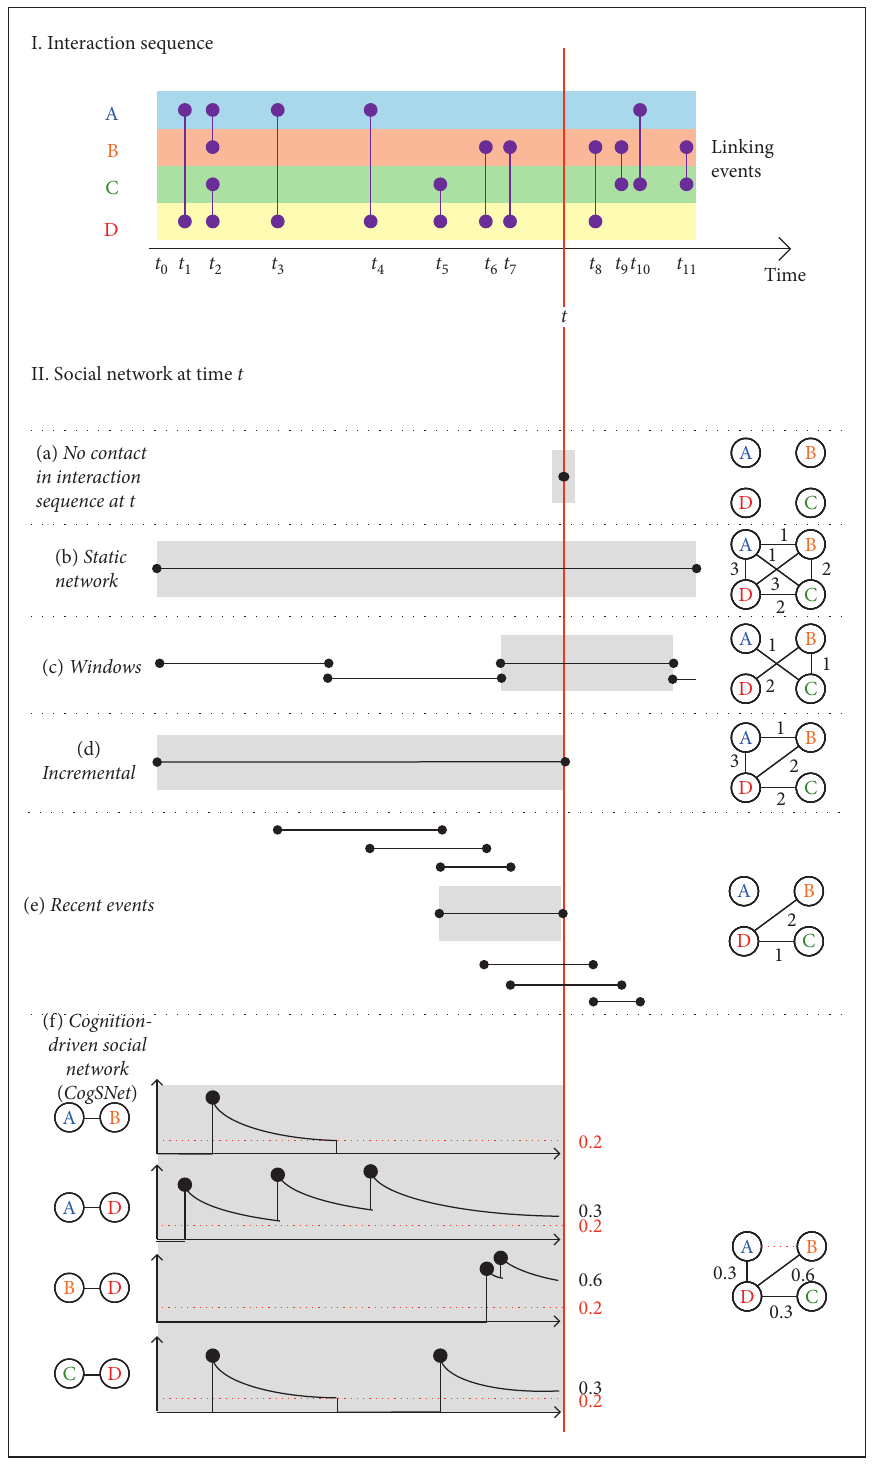
Figure 1: Various approaches to modeling dynamic networks and edge weighting (relation strengths) for the 4-node network at a given time t : (I) and (IIa) interaction sequence; (IIb) static (time-aggregated) network; (IIc) sliding windows; (IId) incremental network, all events from the beginning time t to the current time t are considered, and the frequency of interaction in the period constitutes the frequency-based 0 (FQ) reference; (IIe) network based on n � 3 recent events, used for recency-based reference RC; (IIf) cognition-based social network model (CogSNet), introduced